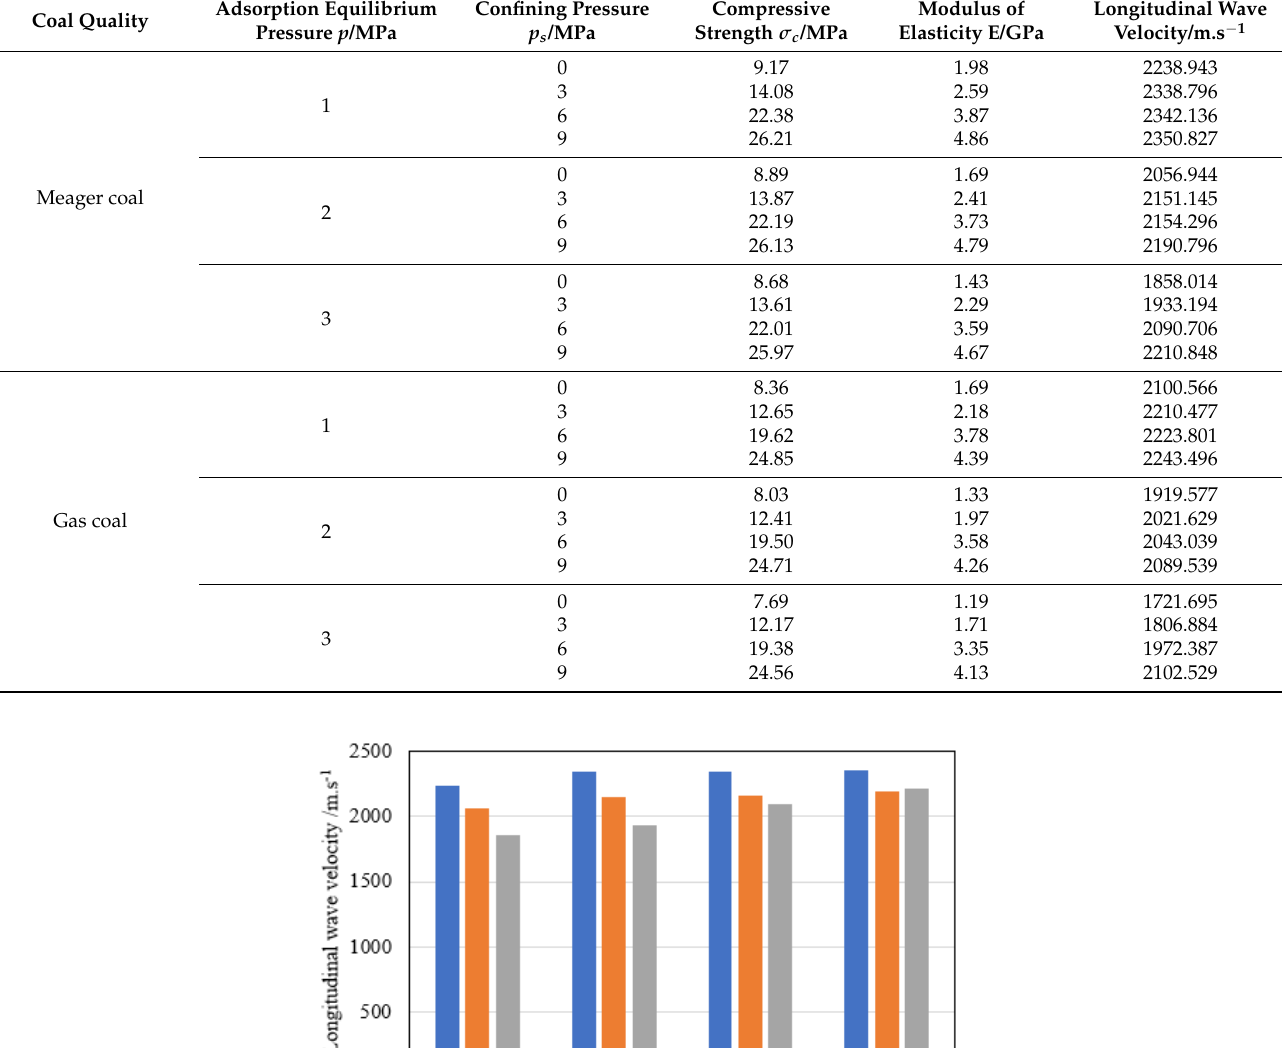
Table 1. Experimental results.